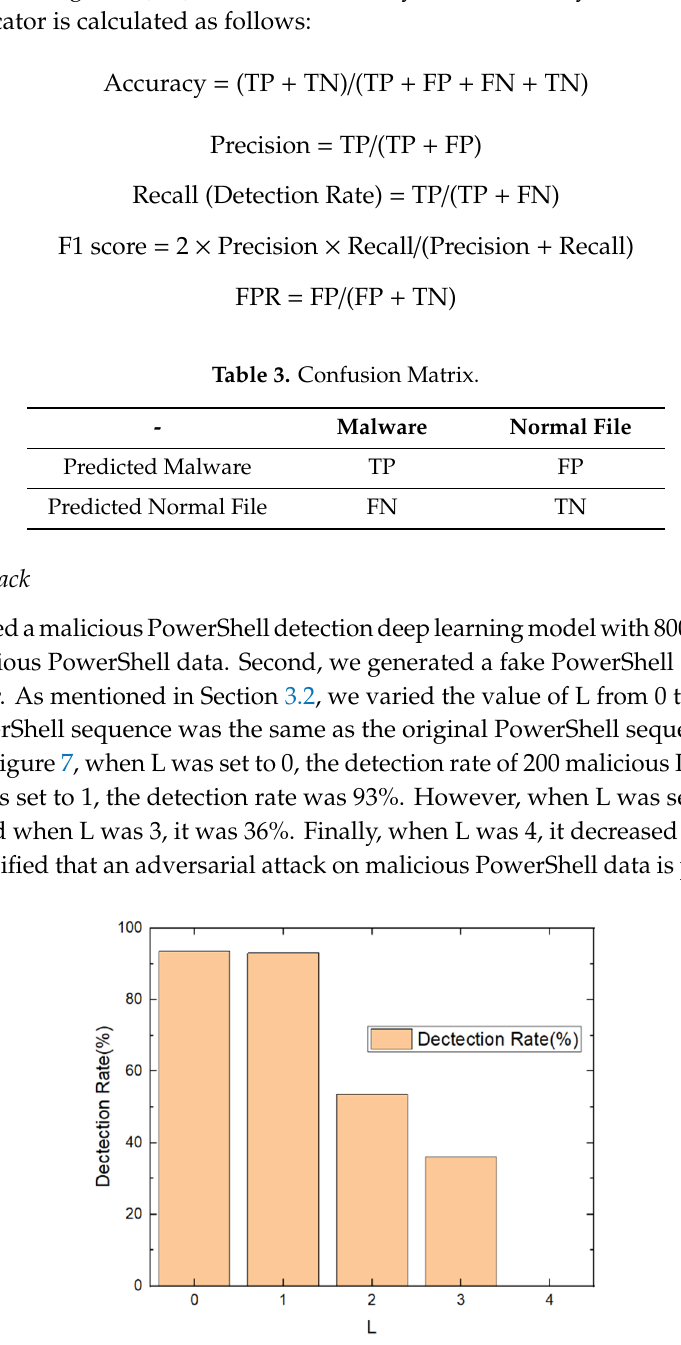
Table 3. Confusion Matrix.